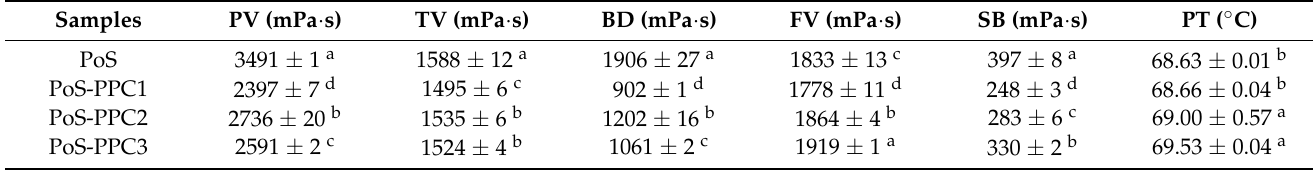
Table 1. Gelatinization characteristics of PoS and PoS-PPC complexes.